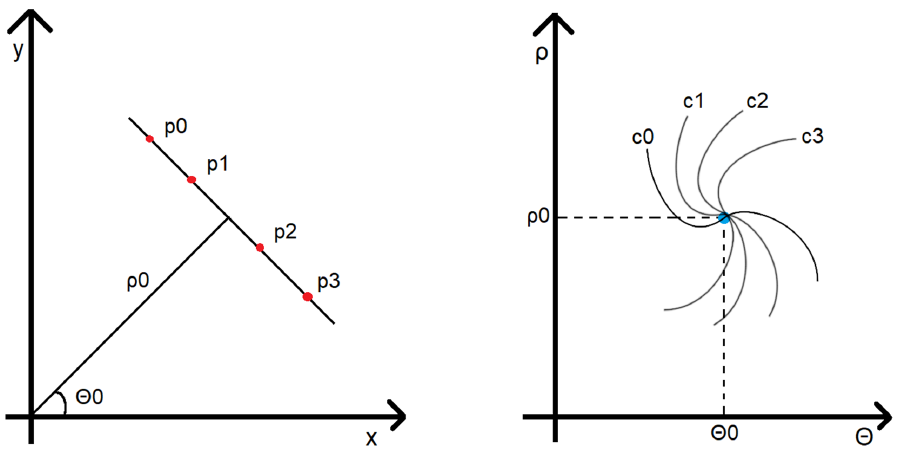
Figure 9. Hough transform example.